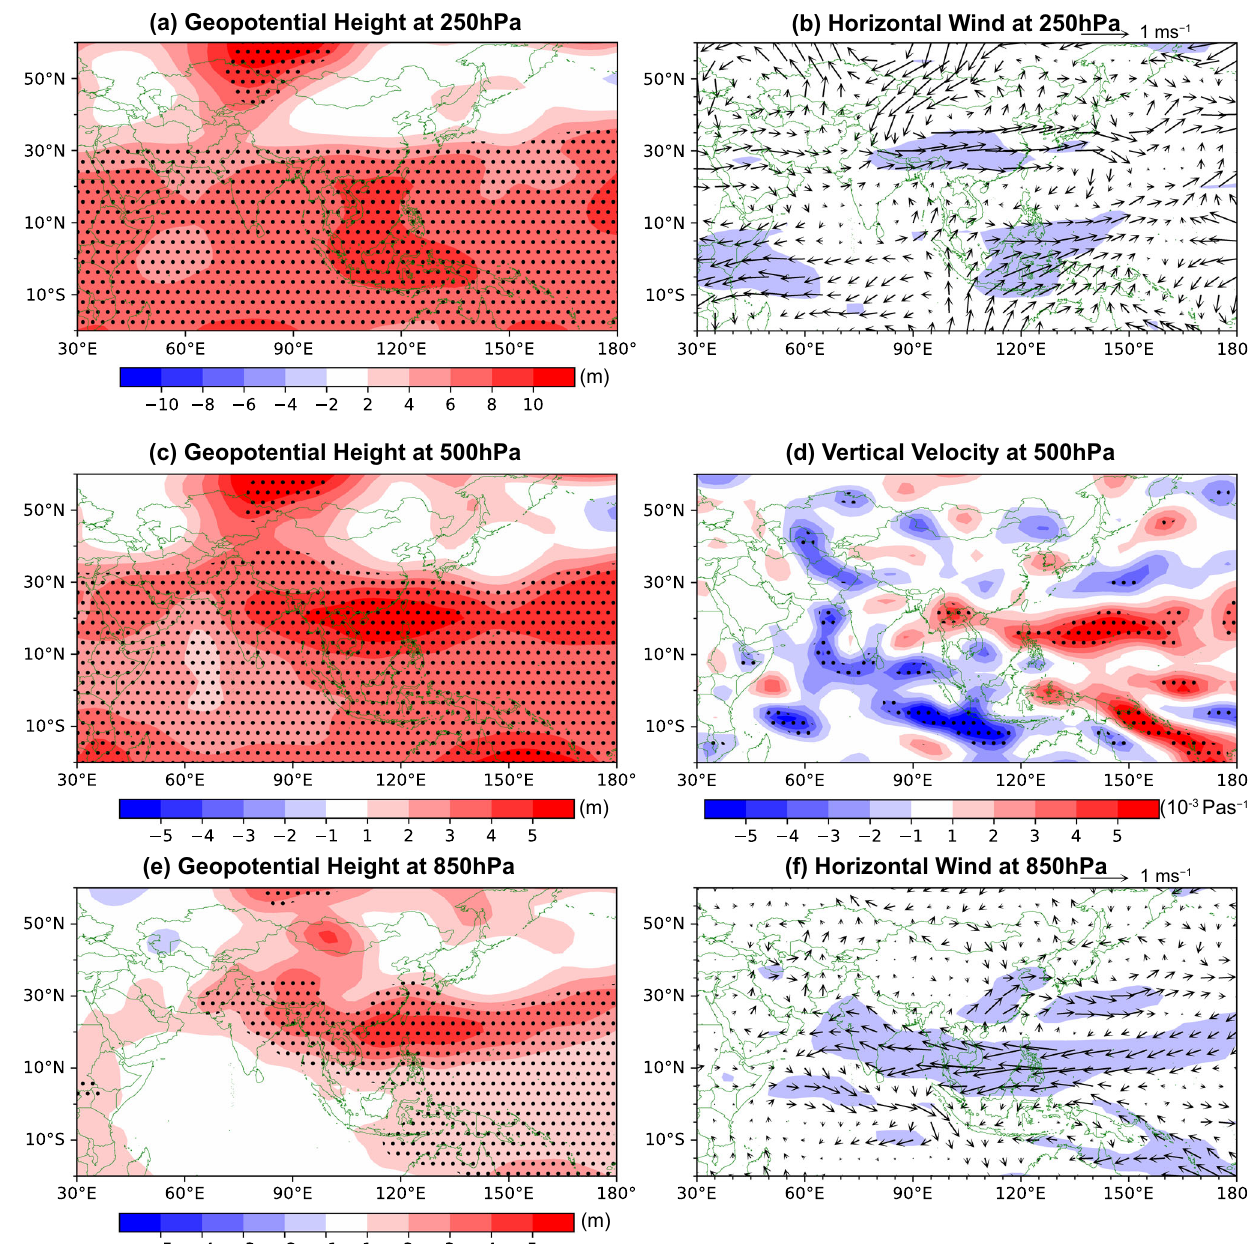
Fig. 7 Summer atmospheric changes associated with the preceding winter ENSO. a , b regression of summer geopotential height ( a ) and horizontal wind ( b ) at 250 hPa onto the winter Niño3.4 index. c , d As ( a ) and ( b ) but for geopotential height ( c ) and vertical velocity ( d ) at 500 hPa. e , f As ( a ) and ( b ) but for geopotential height ( e ) and horizontal wind ( f ) at 850 hPa. Black dots in a , c – e) indicate that the regression coef fi cient is signi fi cant at the 0.05 level. Light blue shadings in b , f denote signi fi cance at the 0.05 level for either zonal or meridional component of the horizontal